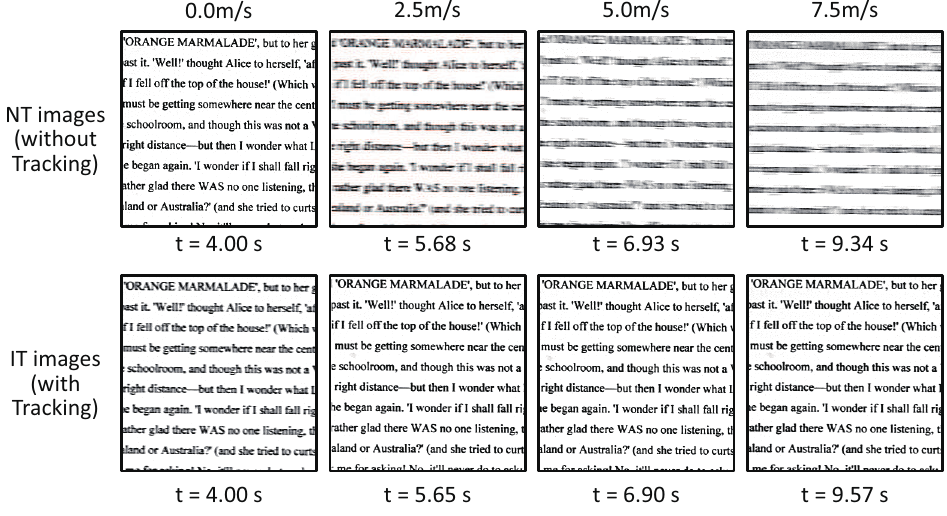
Figure 22. Images captured when a book page with many letters moved at variable